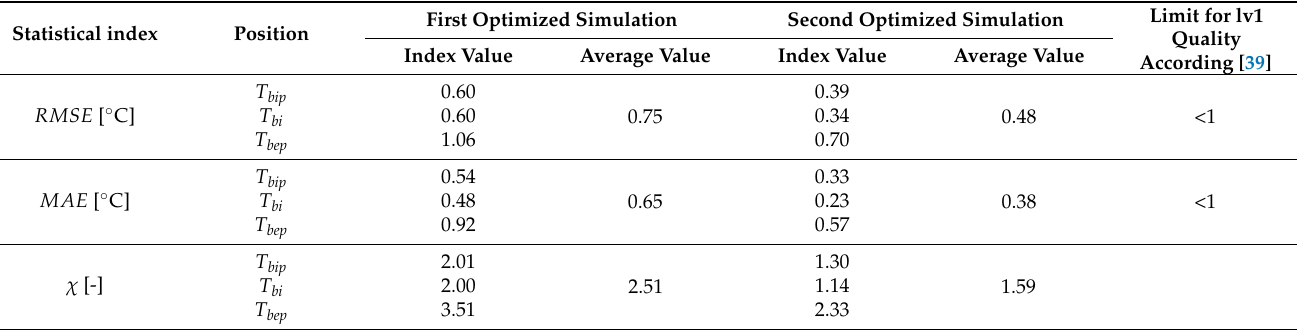
Table 6. Statistical index RMSE, MAE and χ RMSE for each position. First optimized simulation (left column) and second optimized simulation are compared with the value given from [39] for a LV1